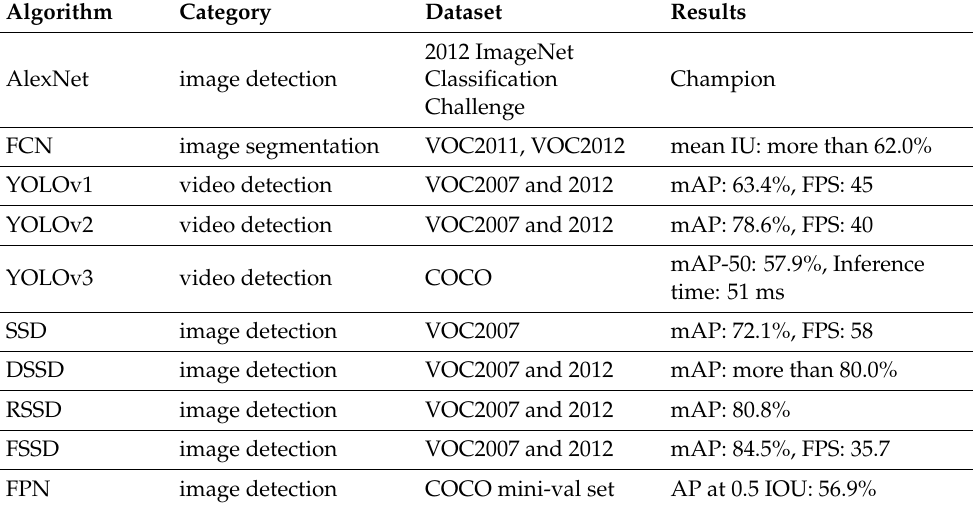
Table 2. The state-of-the-art one-stage video detection algorithms. The image detection algorithms can be used to detect videos by the way of frames. FPS denotes frame per second.